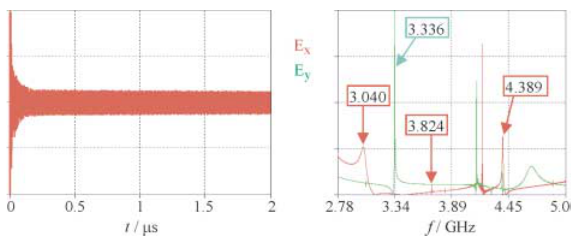
FIG. 5. (Color) Amplitude signal of one of the virtual antennas (left) and spectra of some E -field antennas as a result from the DFT (right).